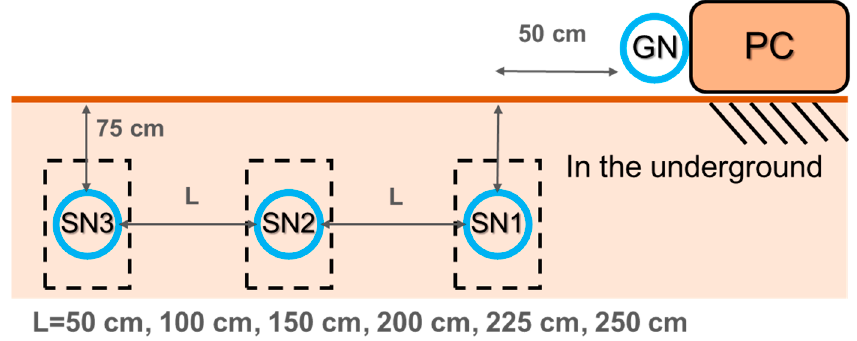
Figure 6. Experimental setup diagram of the multi-hop underground transmission test.